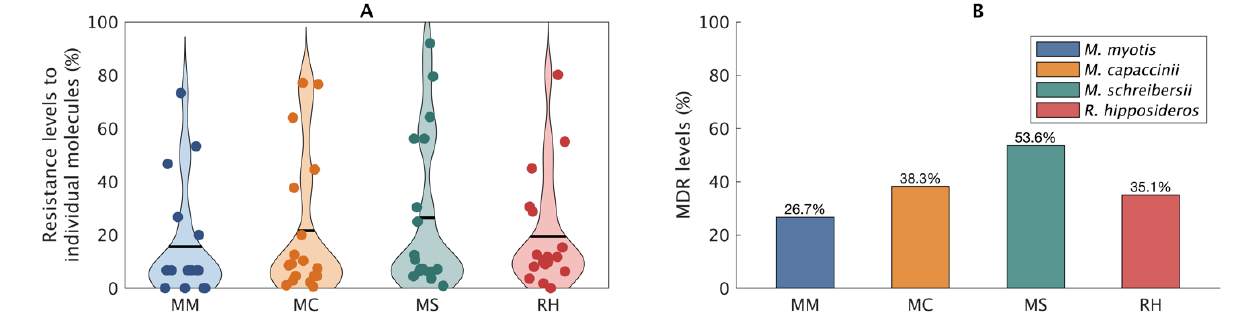
Figure 4. ( A ) Resistance levels to individual molecules and ( B ) percentage of multi-drug resistant (MDR) strains in different bat species. Figure legend: MM = M. myotis , MC = M. capaccinii , MS = M. schreibersii , RH = R. hipposideros .